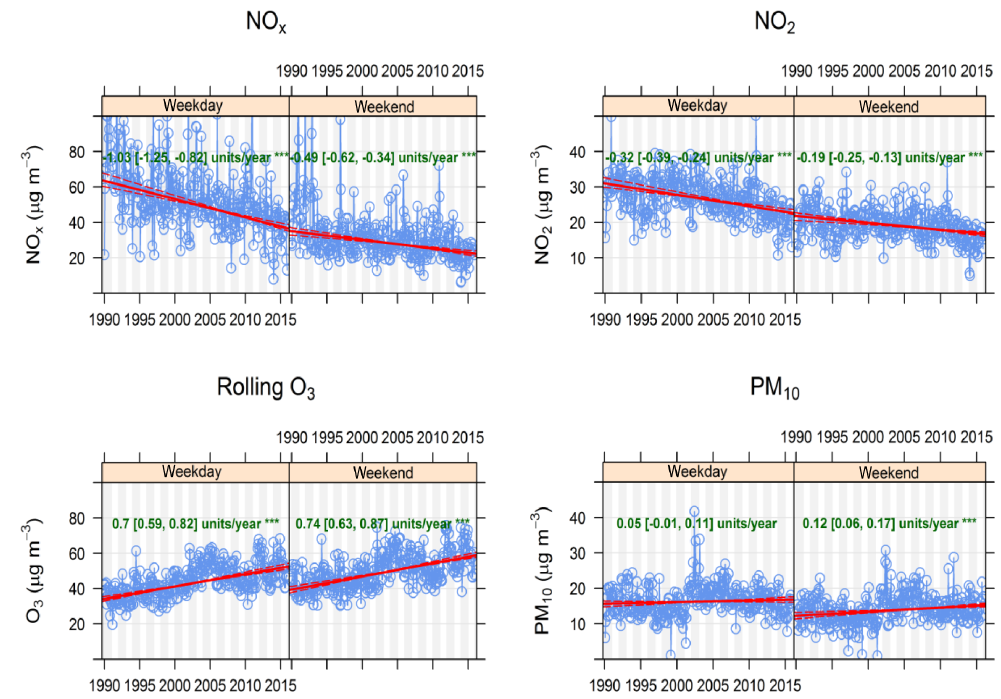
Figure 7. Gothenburg: the trends for NO x , NO 2 , O 3 , and PM 10 , divided into weekdays and weekends.